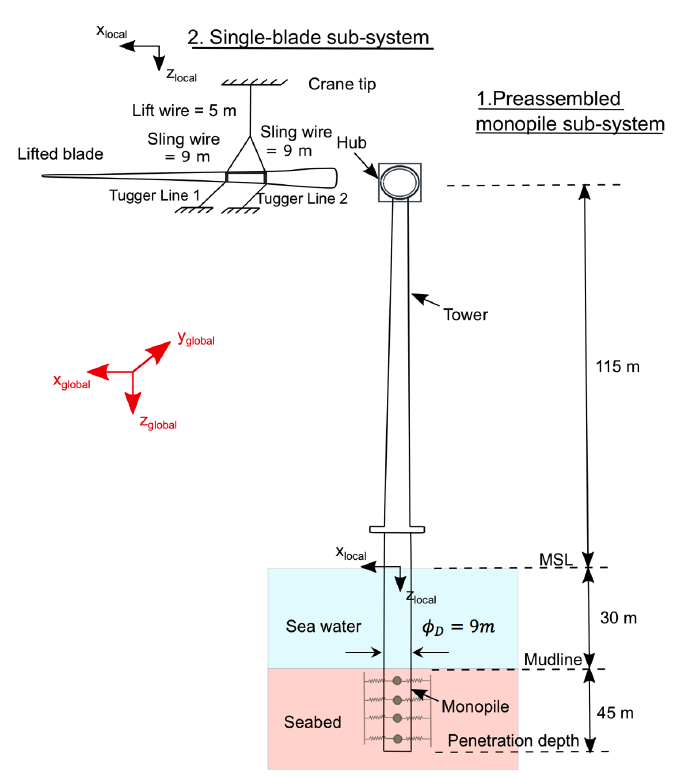
Figure 6. Numerical modelling of installation system in